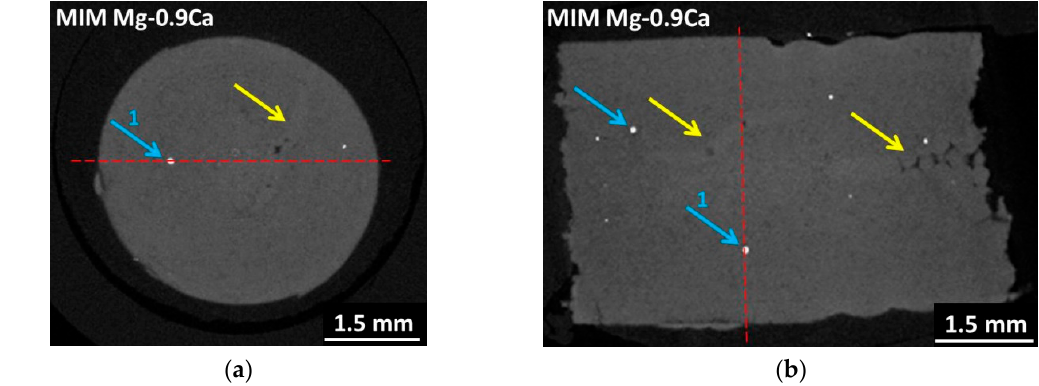
Figure 6. Non-destructive X-ray micro-tomography of thermal debond and sintered MIM specimens after 64 h sintering time using PPcoPb copolymer showing injection molding defects (yellow arrows) as well as titanium particles (blue arrows pointing at white dots). The red dotted line shows the section plane of the corresponding adjacent